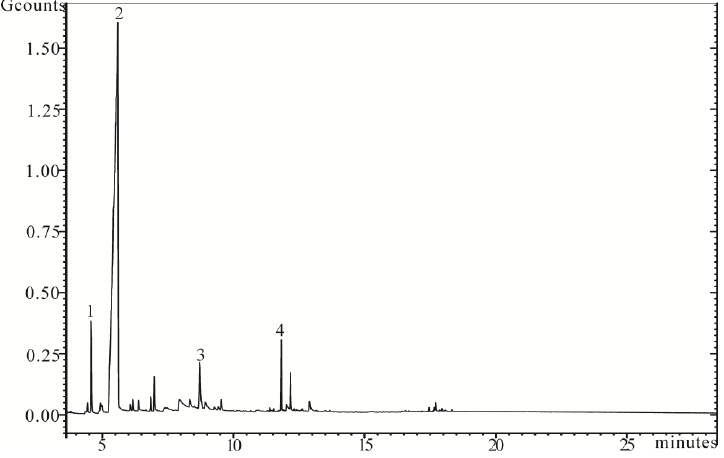
Figure 2. Py-GC/MS abundance-retention time curve of non-treated PLA. Table 2. Main pyrolysis derivatives along with their peak area % of total obtained from Py-GC/MS for non-treated PLA.